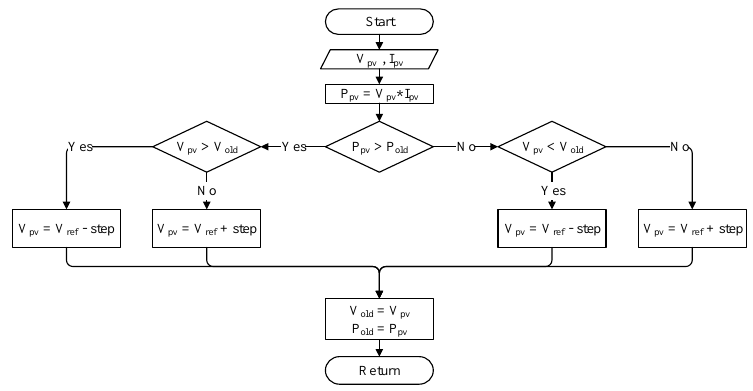
Figure 5. The flowchart of conventional P&O .